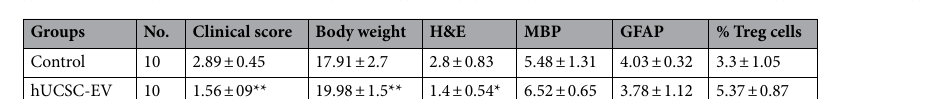
Table 1. Clinical and pathological features of EAE-treated mice. The parameters of hUCSC- and hUCSC- EVs-treated mice compared to control mice. GFAP glial fibrillary acidic protein, hUCSC-EV human umbilical cord-derived mesenchymal stem cell-extracellular vesicle, H&E hematoxylin and eosin, MBP Mmyelin basic protein, SD standard deviation, Treg T regulatory. **p < 0.01. *p < 0.05.